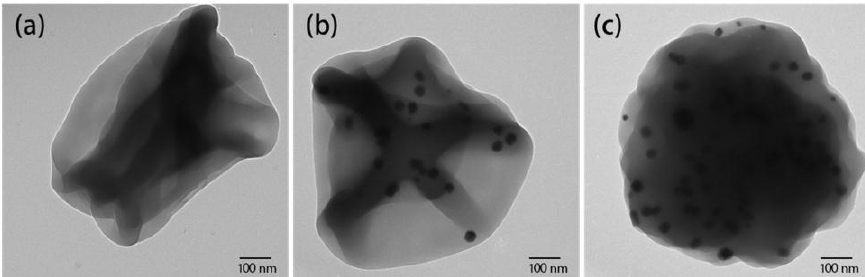
Figure 3. Transmission electron microscopy images of zein/Ag nanoparticles electrospun from ethanol aqueous solutions with an ethanol/water ratio of 8/2 ( v/v ) at Ag concentrations of ( a ) 0, ( b ) 2 and ( c ) 4 wt % (polymer concentration = 10 wt %, TCD = 15 cm, and applied voltage = 15 kV).